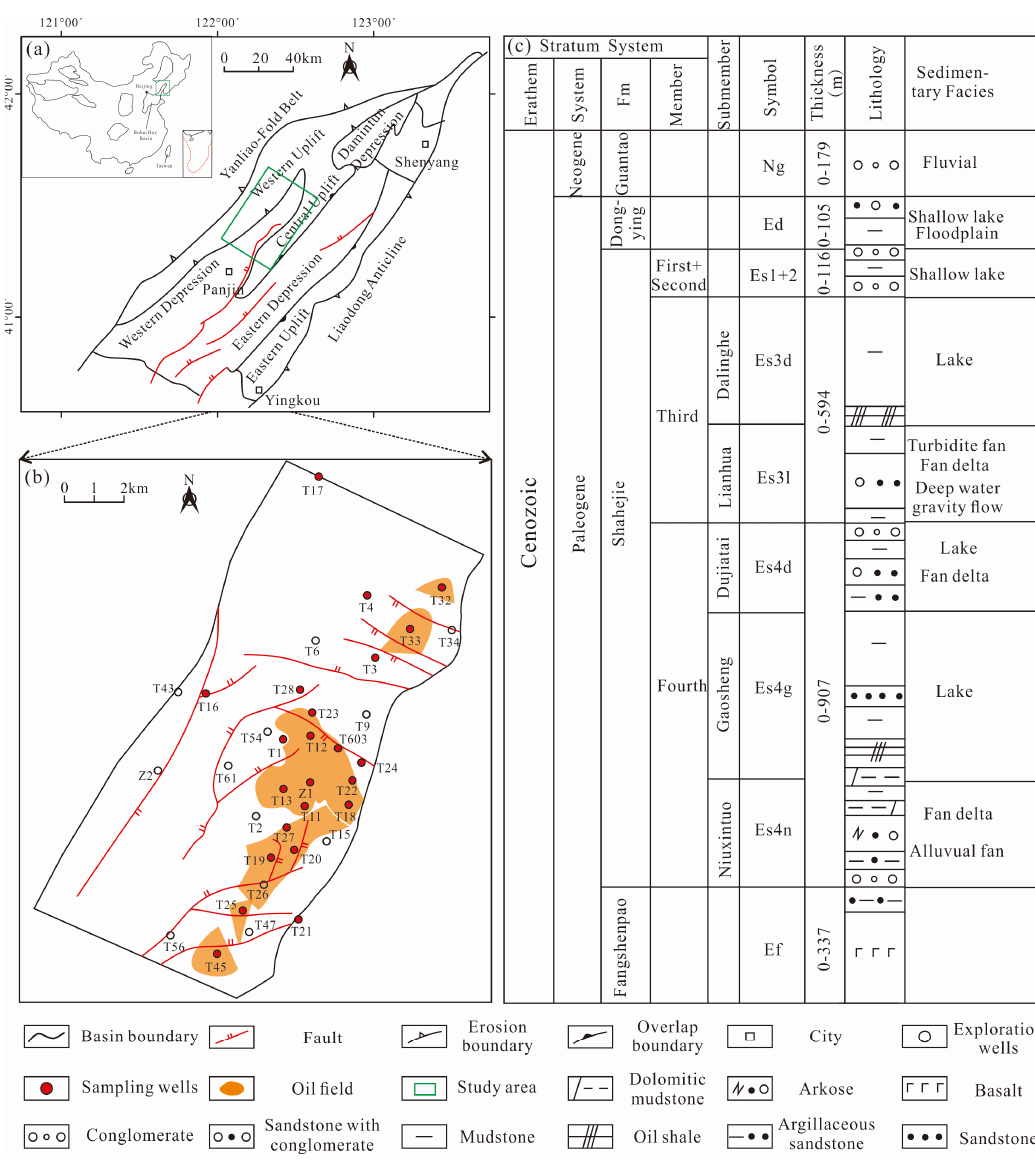
Figure 1. Map of the structural and stratigraphic characteristics of the Niuxintuo area, Liaohe Western Depression. ( a ) Tectonic units of Liaohe Depression. ( b ) Structural map of the Niuxintuo area. ( c ) Stratigraphic column map.